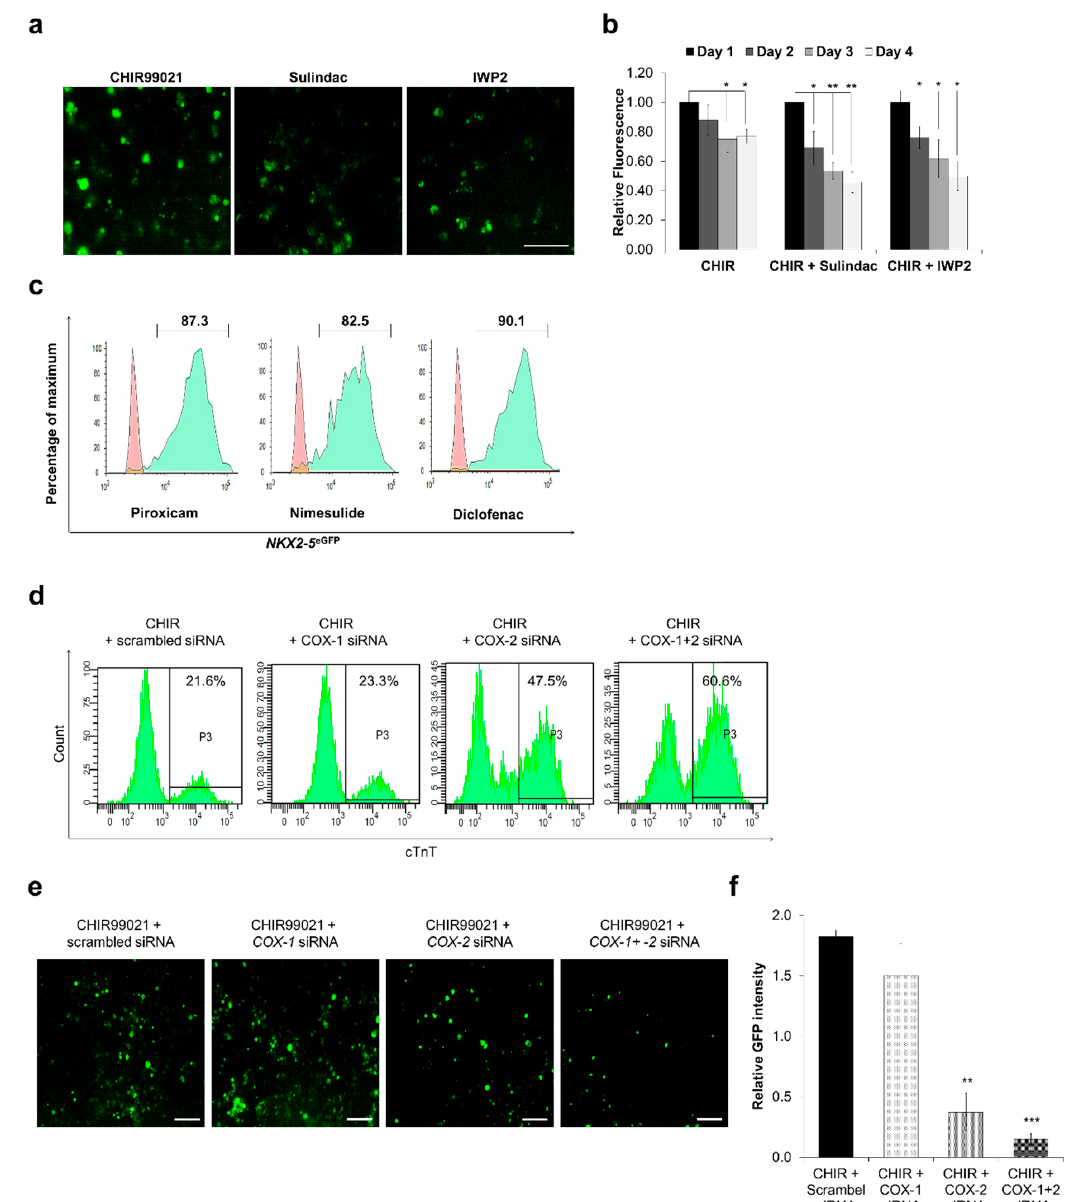
Figure 5. Cyclooxygenase inhibition plays an important role in cardiomyocytes differentiation. TCF reporter assay using IMR90-WNT reporter line: ( a , b ) The effect of Sulindac and IWP2 was examined. On day 0, CHIR99021 (10 μ M) was added to activate Wnt signaling and TCF promoter activity from day 2 to day 4 cells were treated with Sulindac and IWP2. Fluorescence was recorded and images were captured on day 4. Scale bar, 100 μ m ( a ), Error bars, ±SD; n = 3 independent biological replicates, (Student’s t test, * p ≤ 0.05, ** p ≤ 0.01, *** p ≤ 0.001) ( b ); ( c ) Representative FACS analyses for percent eGFP + cells generated using Nimesulide, Diclofenac and Piroxicam. Control (red) indicates undifferentiated HES3 cells. ( d ) Representative FACS analyses for percent cTnT + cells generated using COX-1, COX-2 and COX-1+2 siRNA. Undifferentiated IMR90 cells were used as control. ( e , f ) IMR90-WNT reporter cells were transfected with COX-1, COX-2 and COX-1+2 siRNAs after treatment with CHIR99021. Fluorescence images were captured on day 4 and analysed using ImageJ to obtain relative GFP intensities. Scale bar = 50 μ m, Error bars, ±SEM; n = 3 independent biological replicates, (Student’s t test, * p ≤ 0.05, ** p ≤ 0.01, *** p ≤ 0.001).